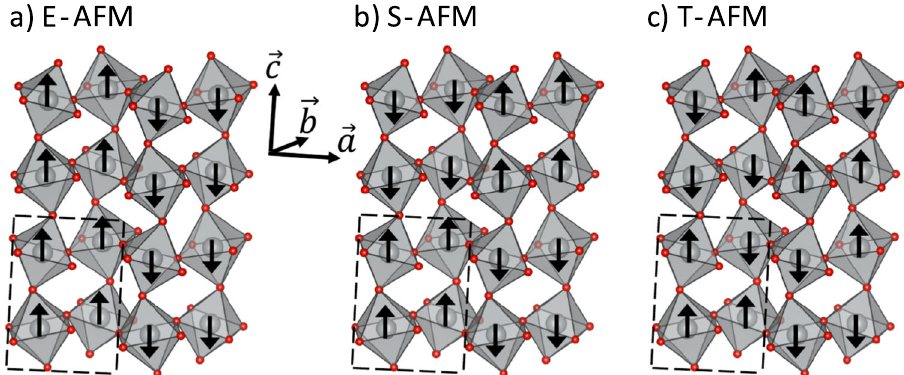
Fig. 1 Sketch of the three complex colinear AFM orderings used in the calculations. a E-type AFM ordering. b S-type AFM ordering. c T -type AFM ordering. The A cations are not displayed for clarity. The dashed lines represent the size of the crystallographic unit